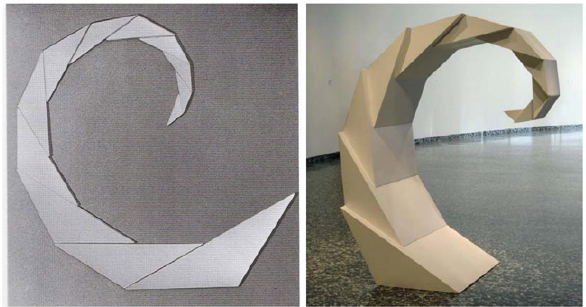
Figure 14. Robert Smithson, Aerial Map-Proposal for DFW Regional Airport (1967) and Gyrostasis